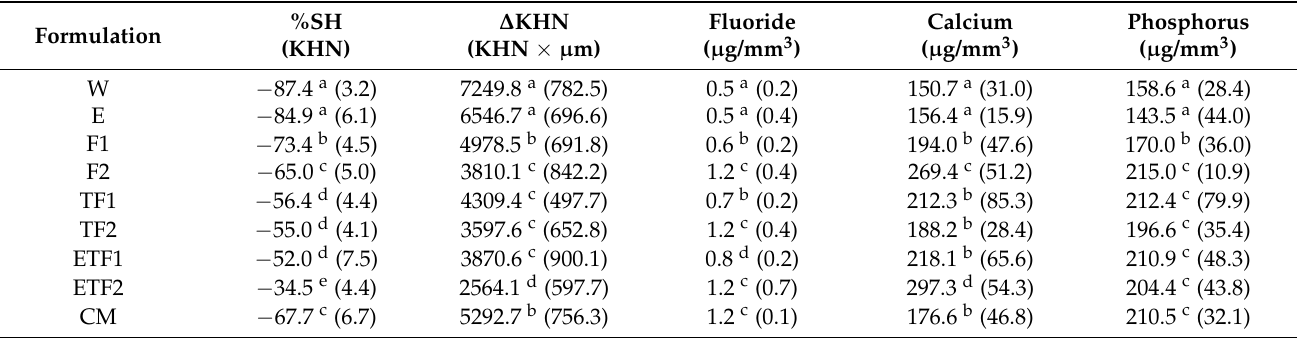
Table 2. Mean and standard deviation of variables’ surface hardness loss (%SH), subsurface hardness integrated loss ( ∆ KHN), fluoride, calcium, and phosphorus analyzed according to mouthwash formulation